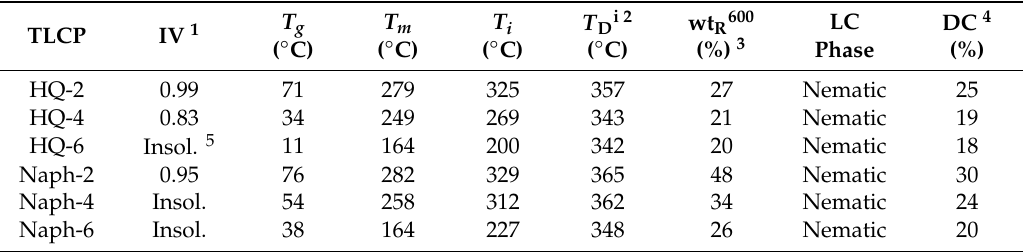
Table 1. General properties of hydroquinone (HQ)- and Naph- thermotropic liquid-crystalline polymers